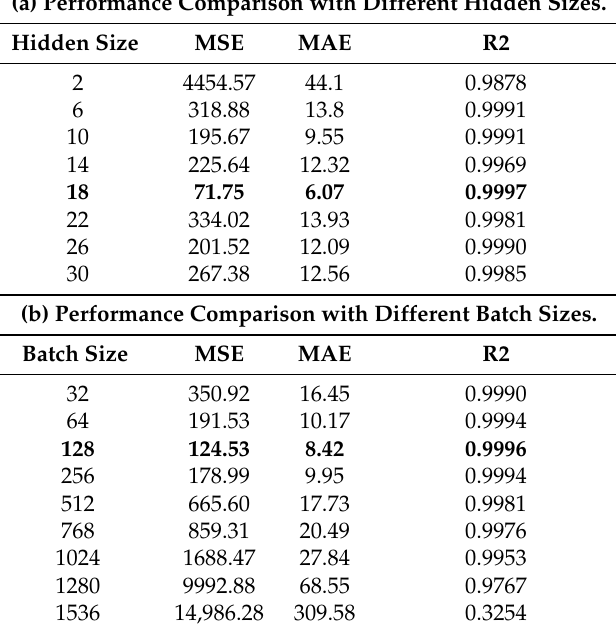
Table 3. Influence of the hidden size and the batch